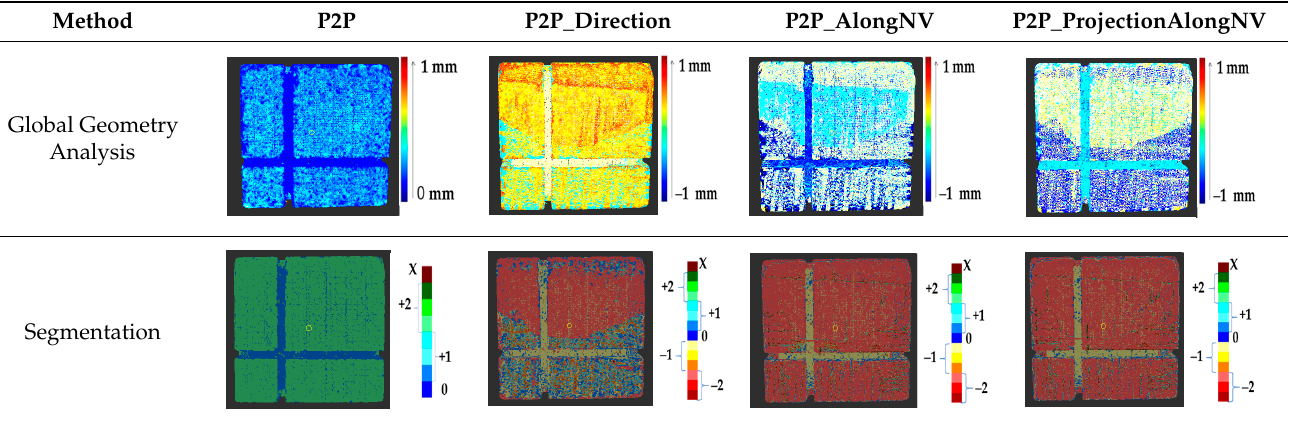
Table 12. Analysis of surface points count on the surface of EL3.